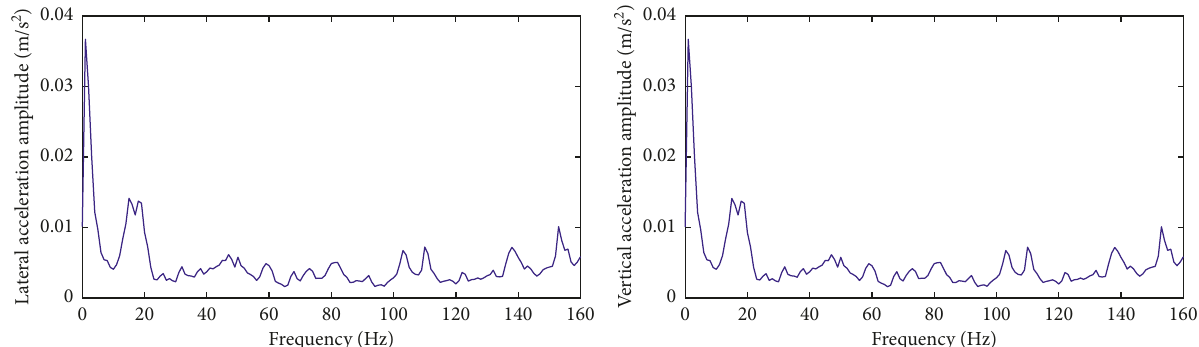
Figure 11: Acceleration data of car body underframe in frequency domain (350